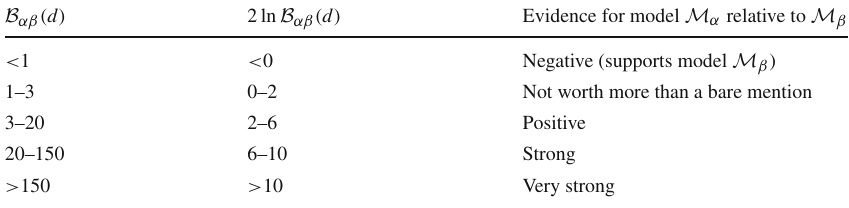
Table 3 Bayes factors and their interpretation in terms of the strength of the evidence in favor of one model relative to the other B αβ ( d